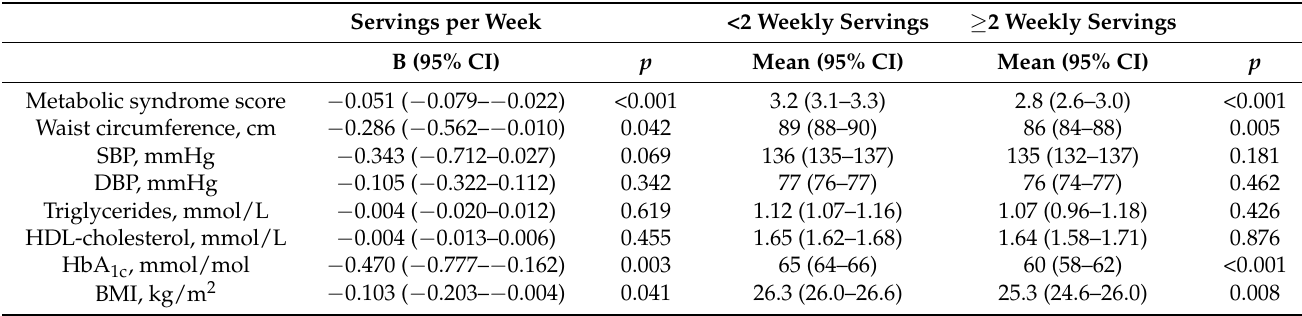
Table 2. Association between nut consumption and metabolic syndrome score, the continuous measures of the individual components of the metabolic syndrome, HbA 1c , and body mass